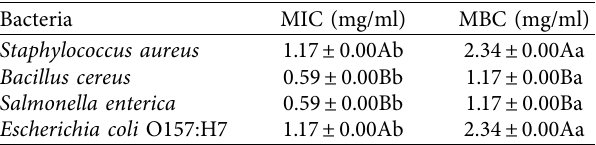
Data represent mean ± standard deviation of three independent repeats. Different capital letters in each column and lowercase ones in each row indicate significant differences ( P <